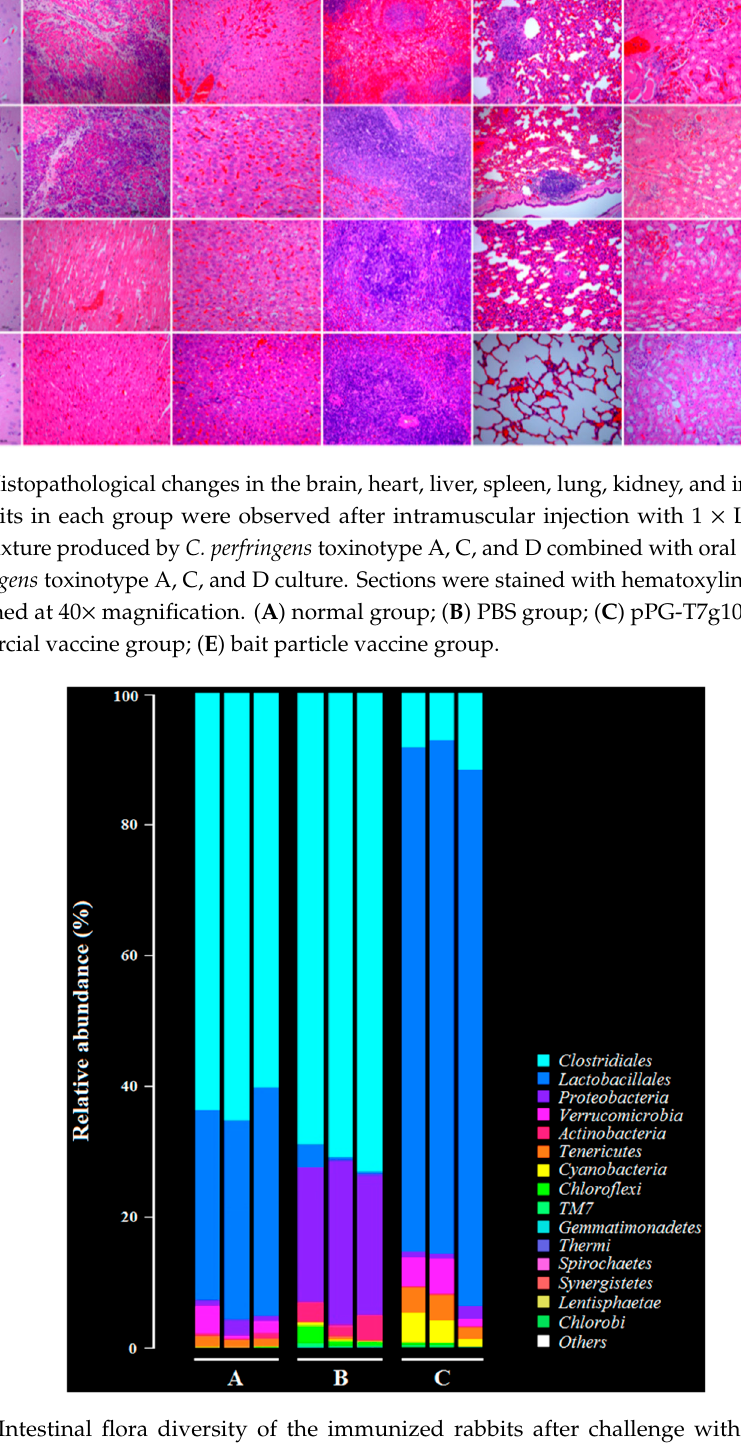
Figure 9. Intestinal flora diversity of the immunized rabbits after challenge with C. perfringens determined by the Illumina MiSeq high throughput sequencing platform targeting 16S rRNA. ( A ) Intestinal flora diversity in normal rabbits. ( B ) Intestinal flora diversity in rabbits challenged with C. perfringens . ( C ) Intestinal flora diversity in immunized rabbits with bait particle vaccine after challenge with C. perfringens .